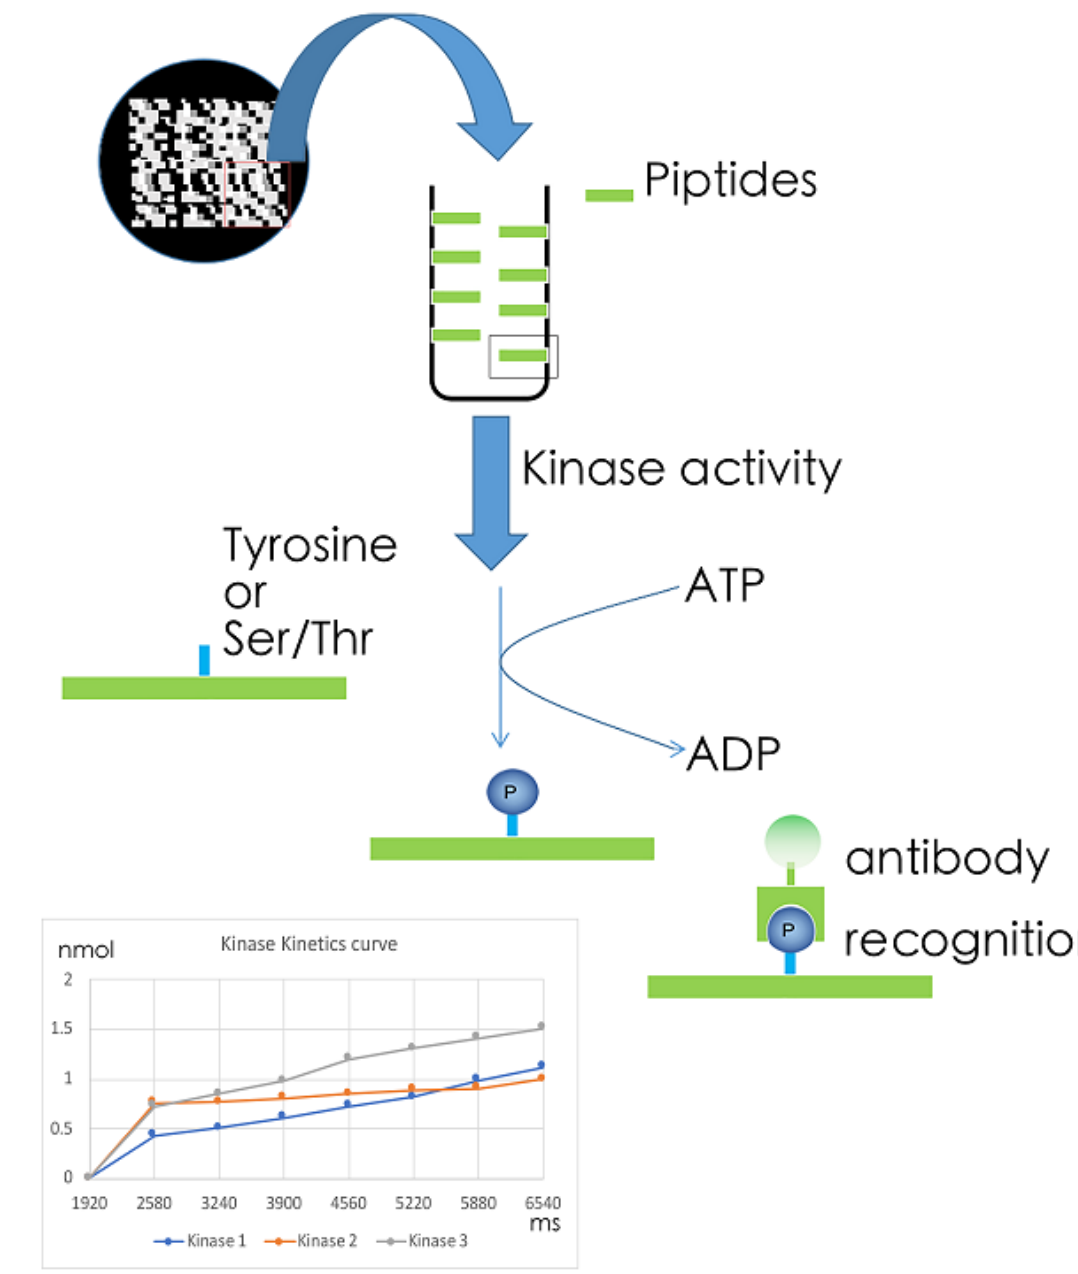
Figure 5. Kinetic kinase target sequence arrays. The microarray assay for kinase activity profiling is based on measuring peptide phosphorylation by protein kinases. The peptide sequences (13 amino acids long) harbor phosphorylation sites. Fluorescently labeled anti-phospho antibodies are used to detect phosphorylation activity of kinases present in the